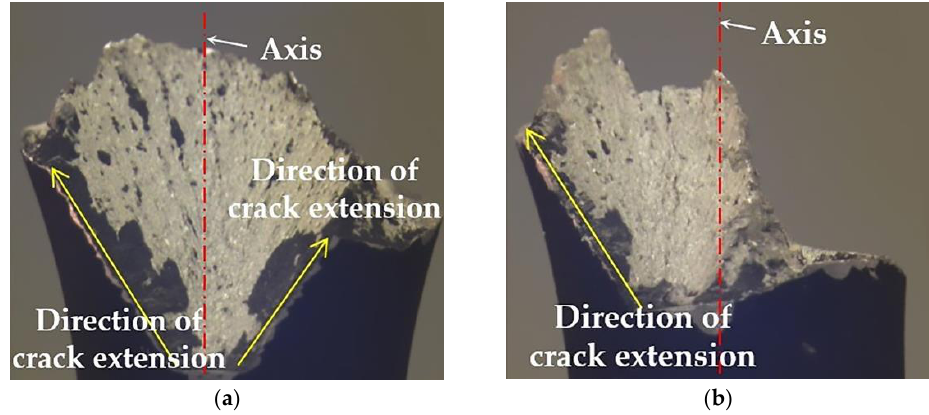
Figure 21. Direction of crack expansion in aluminum alloy samples with different powers ( a ) The first set of test pieces, test power = 30%; ( b ) the third set of test pieces, test power = 45%.